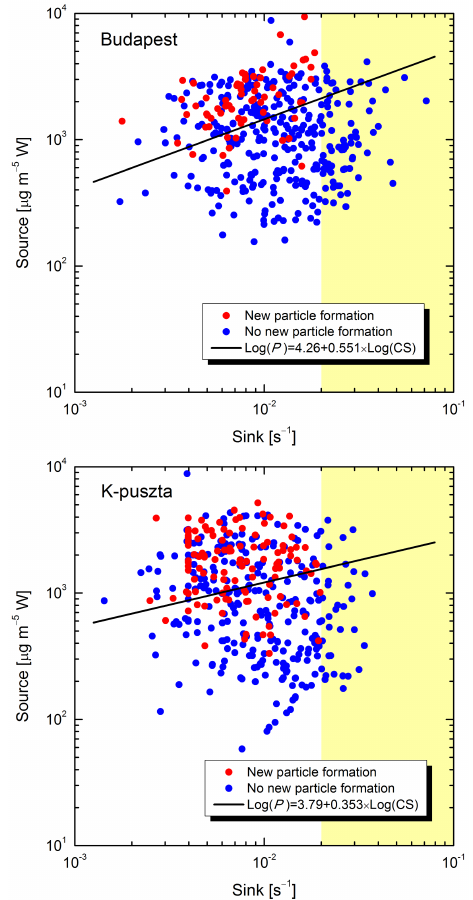
Figure 3. Relationship of the major source and sink of gas-phase H 2 SO 4 . The data are shown separately for the quantifiable-event days and non-event days in Budapest and at the K-puszta station for the whole 2-year-long time interval. Product P of SO 2 concentra- tion and global radiation was considered as the major source and CS as the major sink. The yellow areas indicate the CS range in which the NPF events were suppressed over the whole